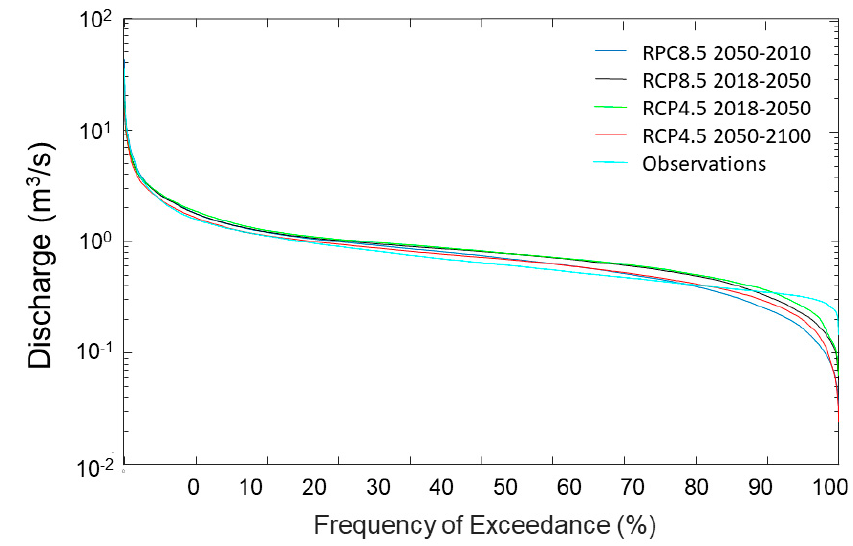
Figure 7. Flow duration curves for observed discharge, and discharge simulated using RCP 4.5 and RCP 8.5 scenarios.3.4. Climate Change Scenarios and Water Temperature